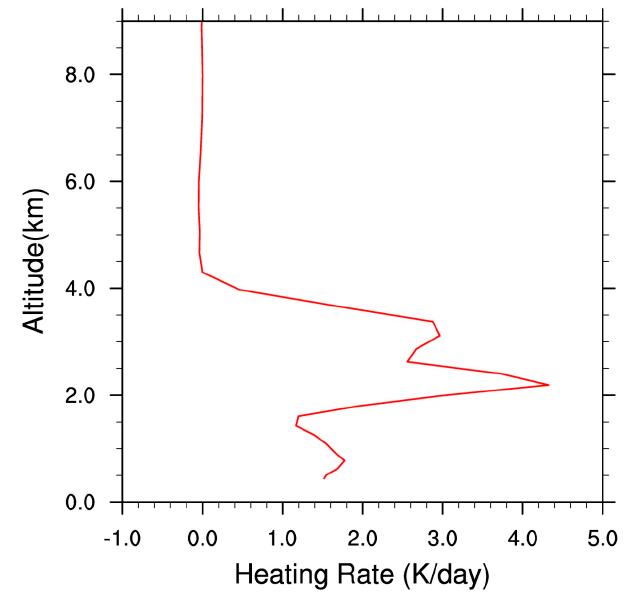
Figure 11. The difference in heating profiles between the SMOKE and CLEAN cases for 0400 UTC 19 August. The heating profiles are averaged over a square area as shown in Figure 8c.